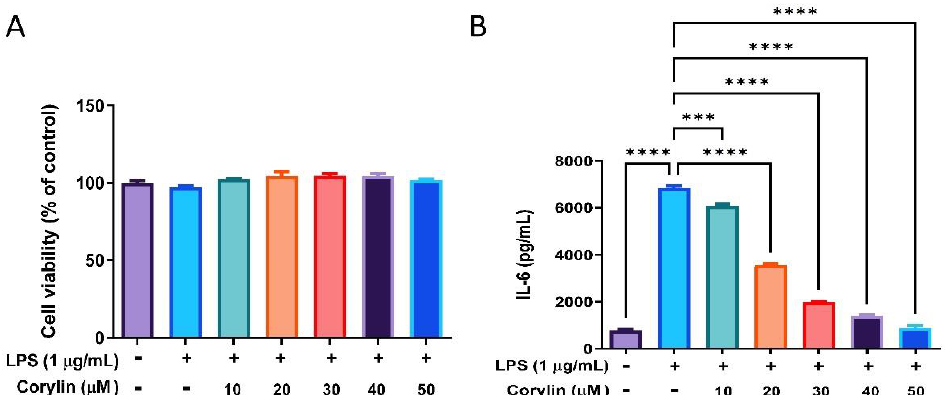
Figure 1. The effects of corylin on the cell viability and the production of IL-6 by LPS-induced HBEC3-KT cells. Cells were pre-treated with different concentrations of corylin (0~50 μM) for 1 h following treatment of LPS (1 μg/mL) for 24 h. ( A ) Cell viability was examined by MTT assay. ( B ) The concentration of IL-6 in the cell culture supernatant was detected using ELISA. The data are presented as means ± SEM of three independent experiments. Statistical significances are represented as follows: *** p < 0.001 and **** p < 0.0001 vs. LPS alone.